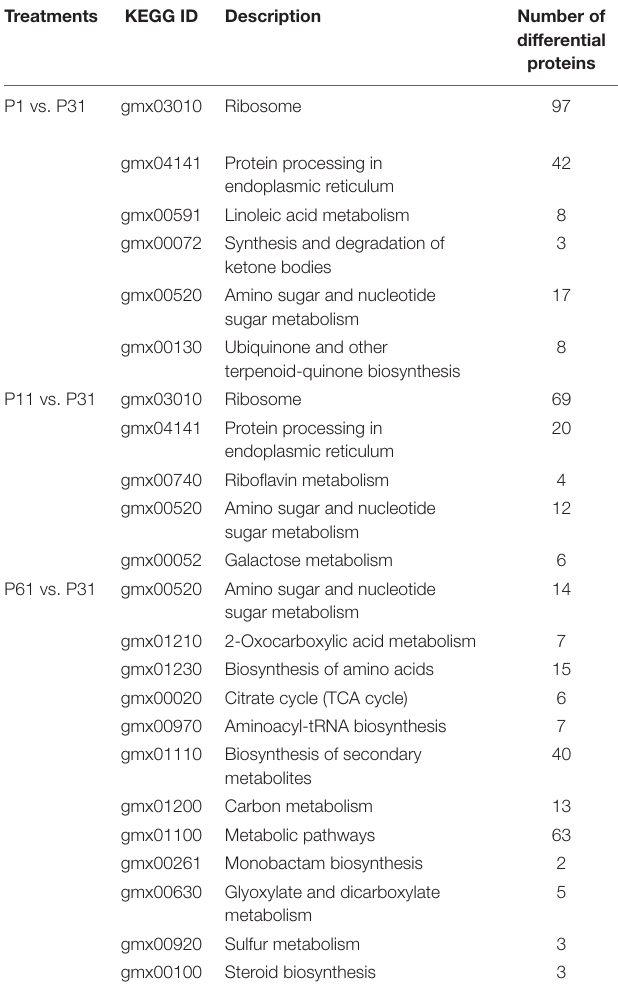
TABLE 1 | Differences of metabolic